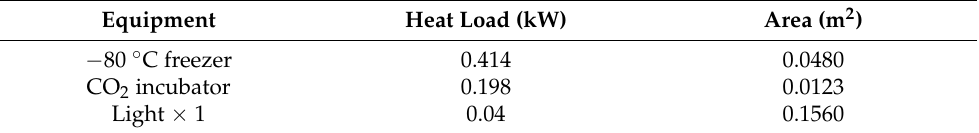
Table 3. Equipment heat load.